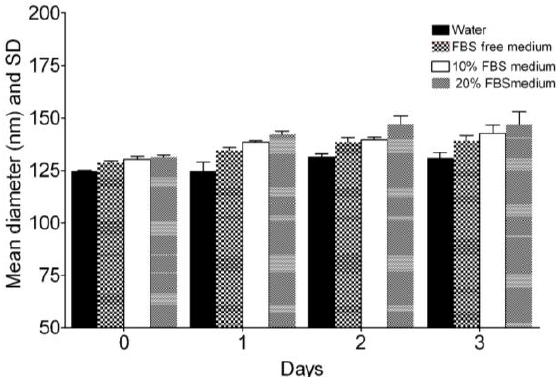
Figure S3. Dynamic light scattering analysis of nanoemulsion M2 dispersed in water, serum-free and serum-containing (10/20% v/v) medium. Error bars represent standard deviation (SD) of three independent samples.